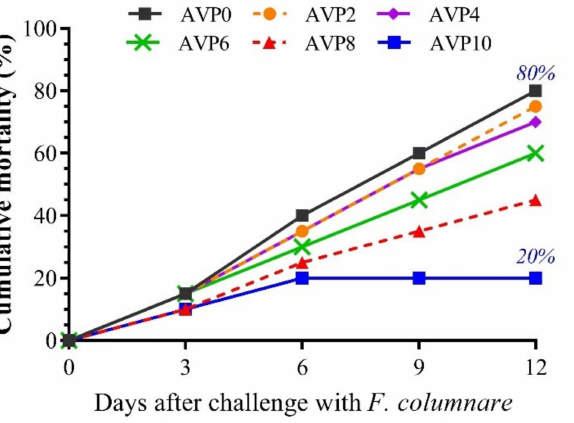
Figure 5. Effect of increasing dietary levels of Alchemilla vulgaris on cumulative mortality percent of Oreochromis niloticus challenged with pathogenic Flavobacterium columnare for 12